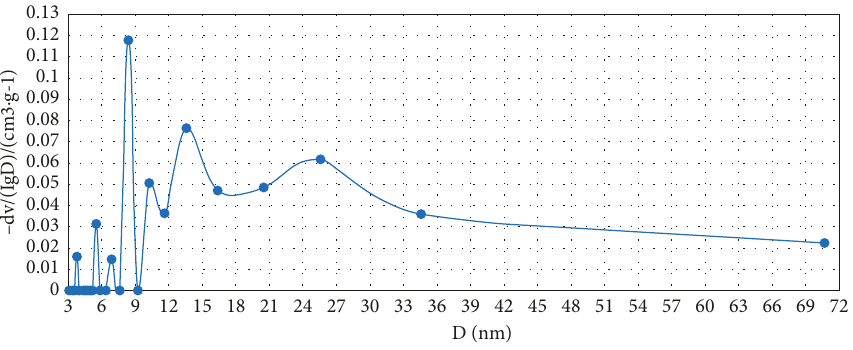
Figure 9: Distribution of pore volume of coal.